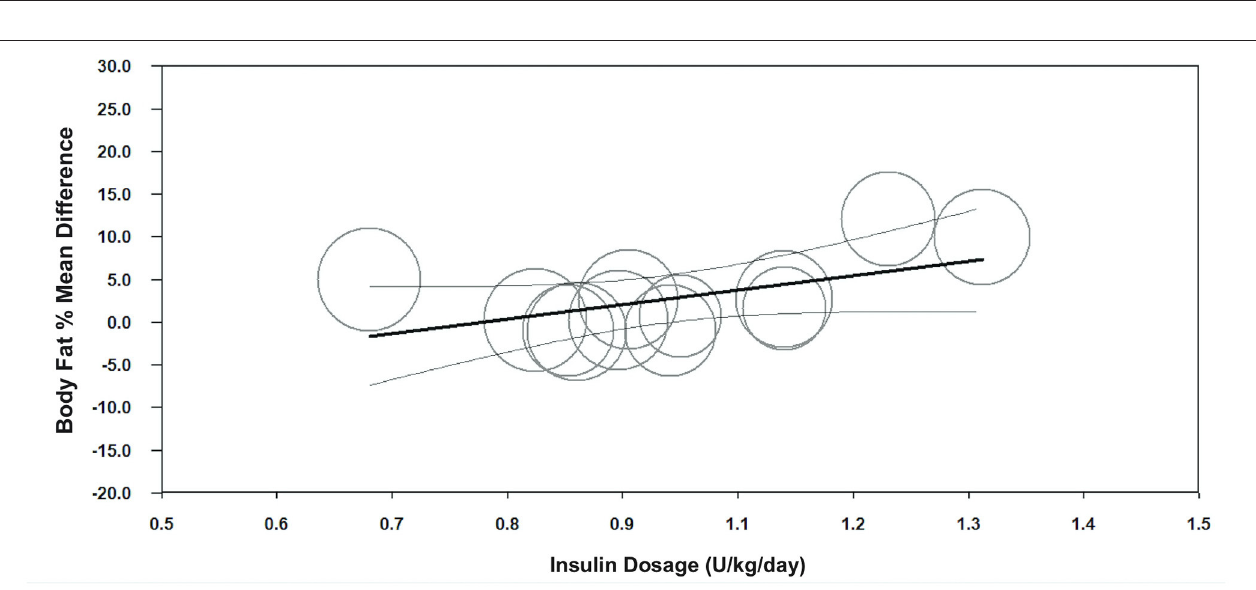
FIGURE 3 | Meta-regression graph illustrating the association between age of onset (years) and body fat % mean difference, with 95% confidence intervals (CI) of body fat % compared children with T1D to TDC. The size of the circles represents the weight given to each individual study in the meta-analysis. Larger circles indicate a higher weighting.